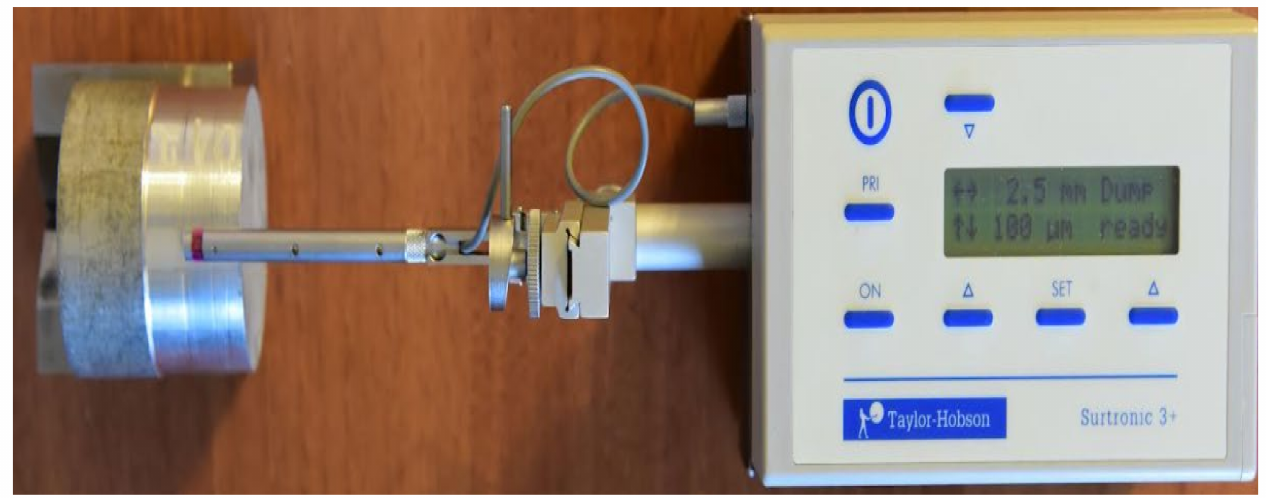
Figure 11. Images with surface roughness obtained by cutting